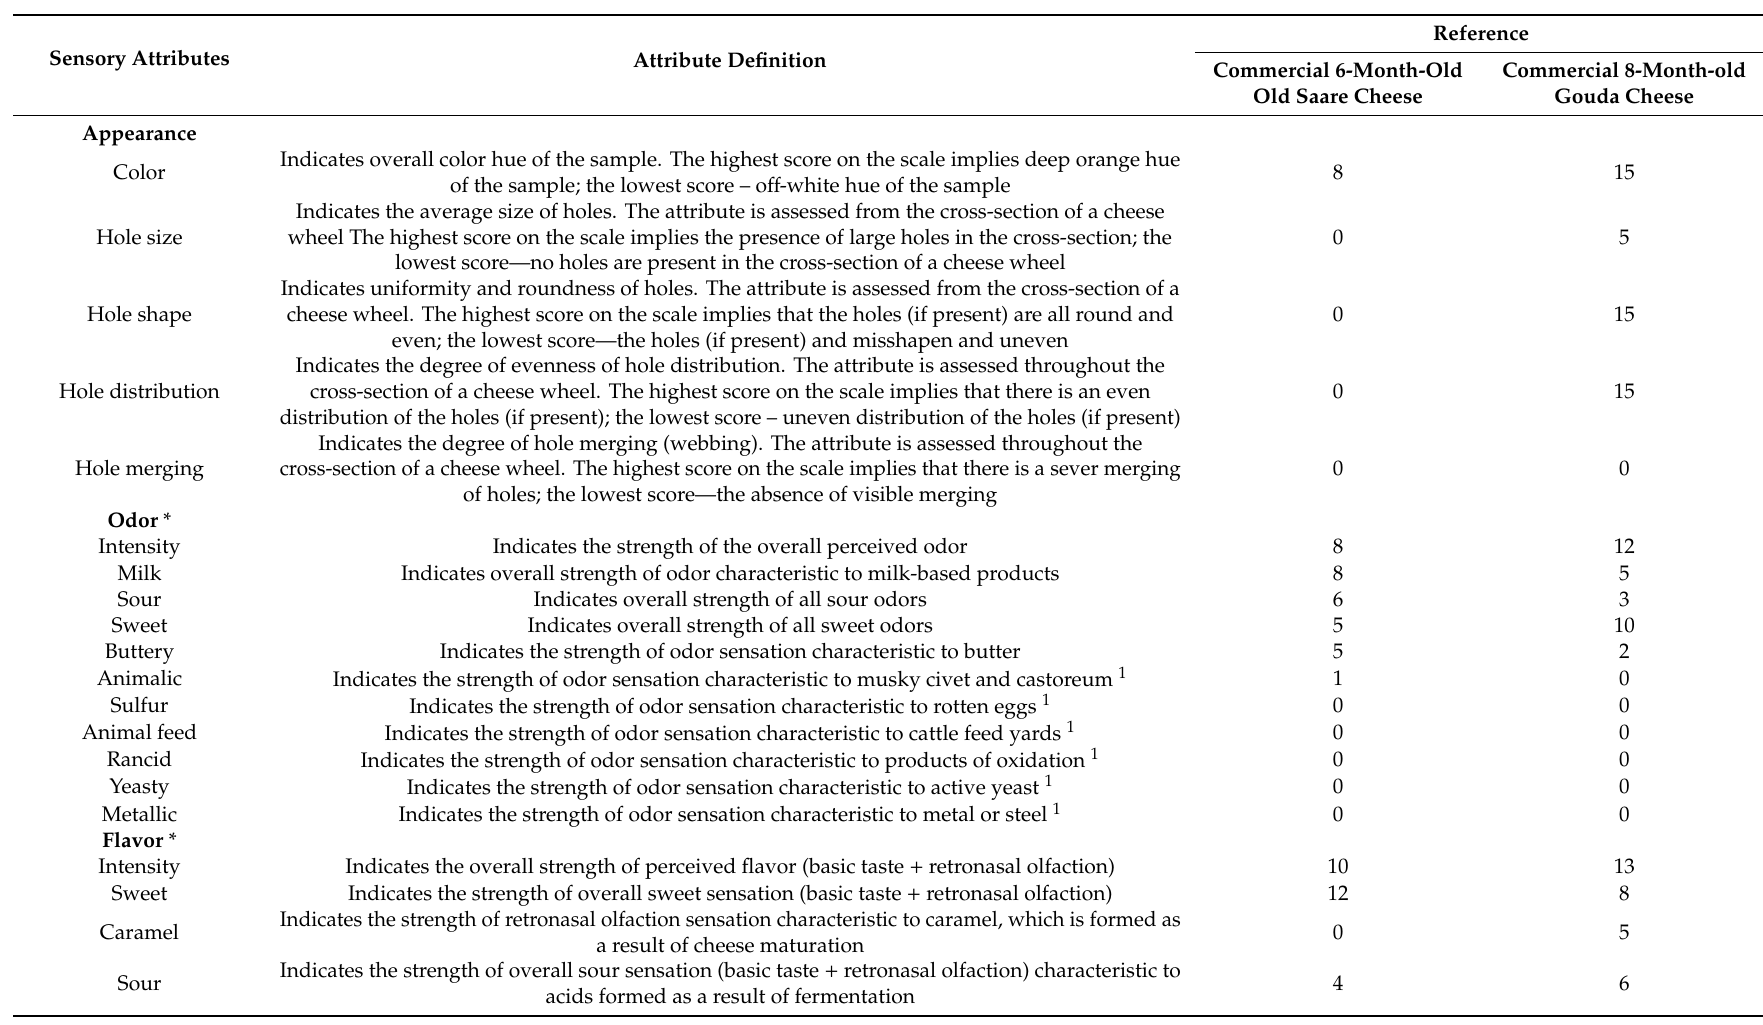
Table 1. A complete list of sensory attributes, attribute definitions, reference materials, and their anchor-values on the